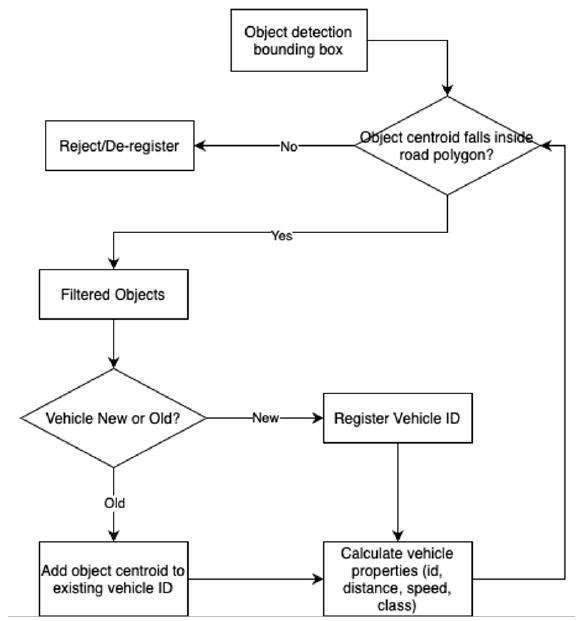
Figure 3: Multi-vehicle Tracking Algorithm for a lane- based count and speed detection of